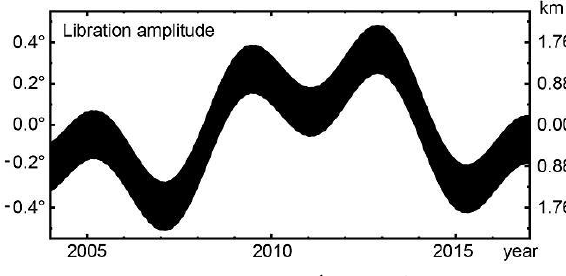
Figure 2: Total libration amplitude (on the left: in degree, on the right: respect to arc lengths along Enceladus’ equator) over a full long-term cycle according to Rambaux et al. (2010). The thickness of the curve masks short-period diurnal librations with amplitude of 0.12 (Thomas et al., 2016).